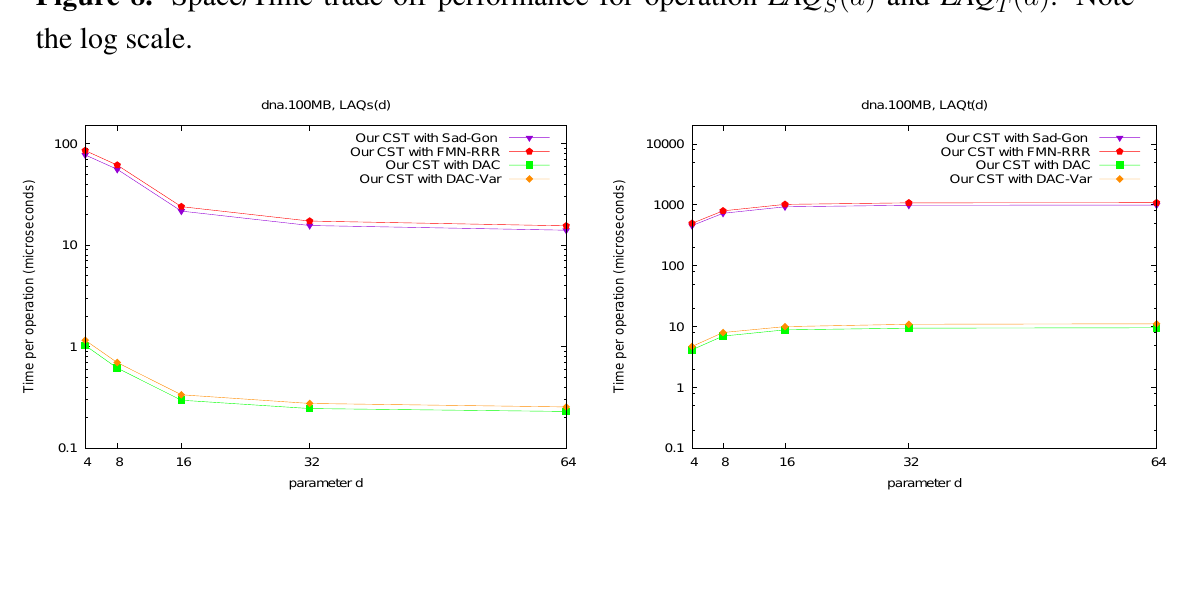
( d ) and LAQ ( d ) . Note S T